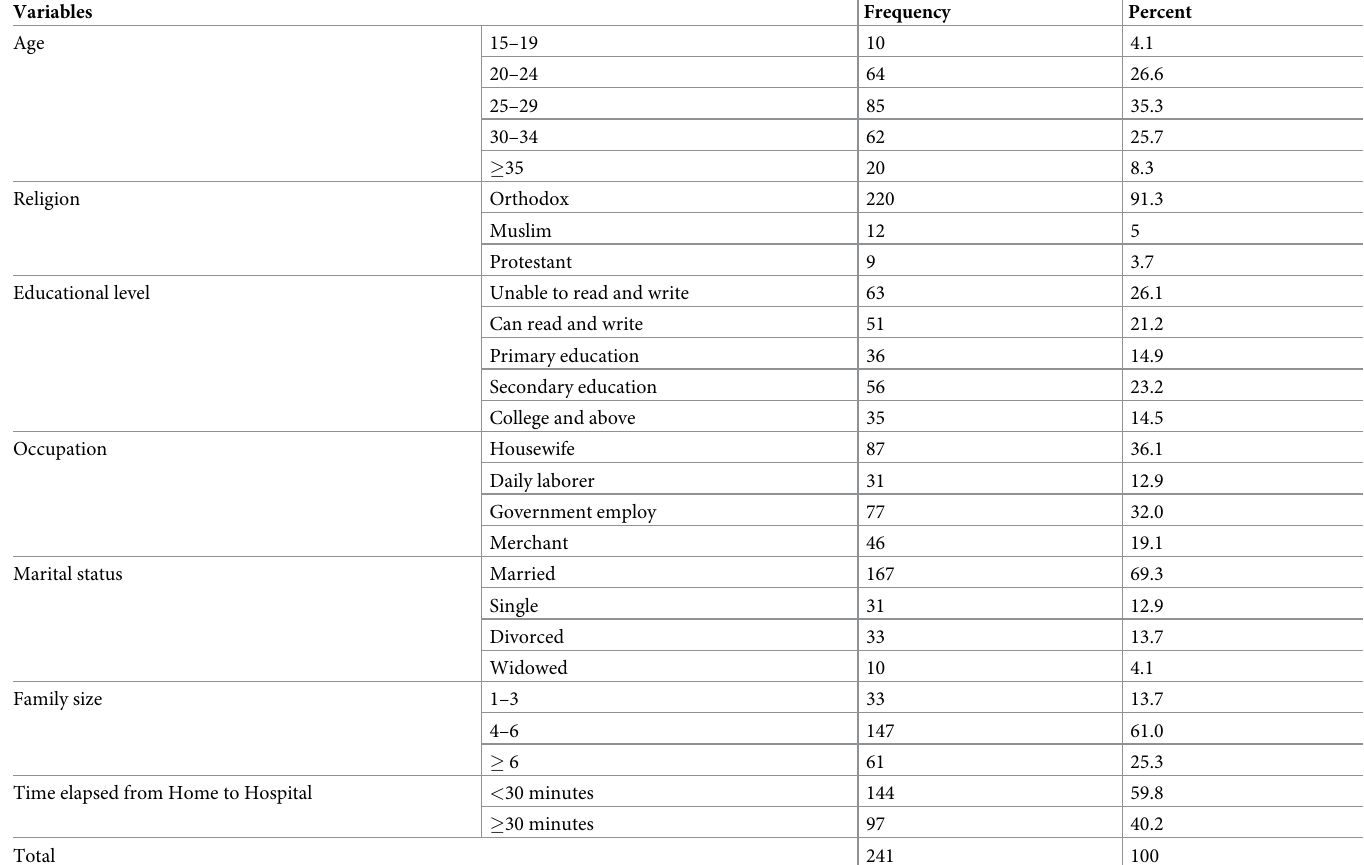
Table 1. Socio-demographic characteristics of pregnant women attending ANC service at Debre Tabor General Hospital, North West Ethiopia, 2017.